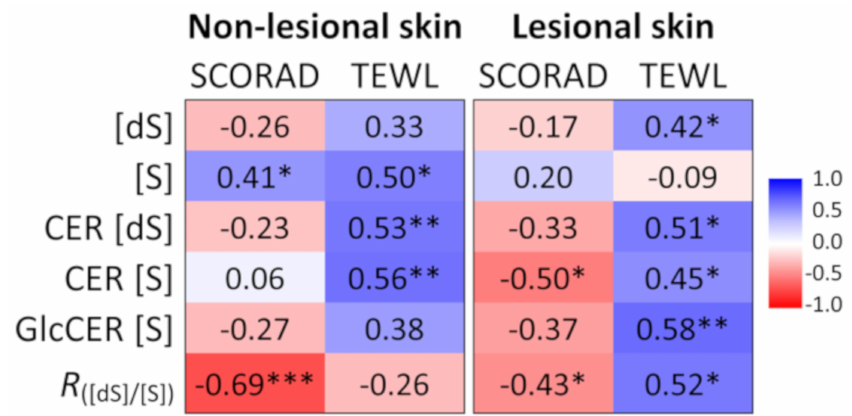
Figure 5. Spearman correlation coe ffi cients between ceramide markers, atopic dermatitis severity (scoring atopic dermatitis, SCORAD) and trans-epidermal water loss (TEWL). (dS) = sphinganine, (S) = sphingosine, CER (dS) = sphinganine ceramides, CER (S) = sphingosine ceramides, GlcCER = glucosylceramide. R [dS] / [S] = ratio between sphinganine and sphingosine. *** p < 0.001, ** p < 0.01, * p < 0.05.